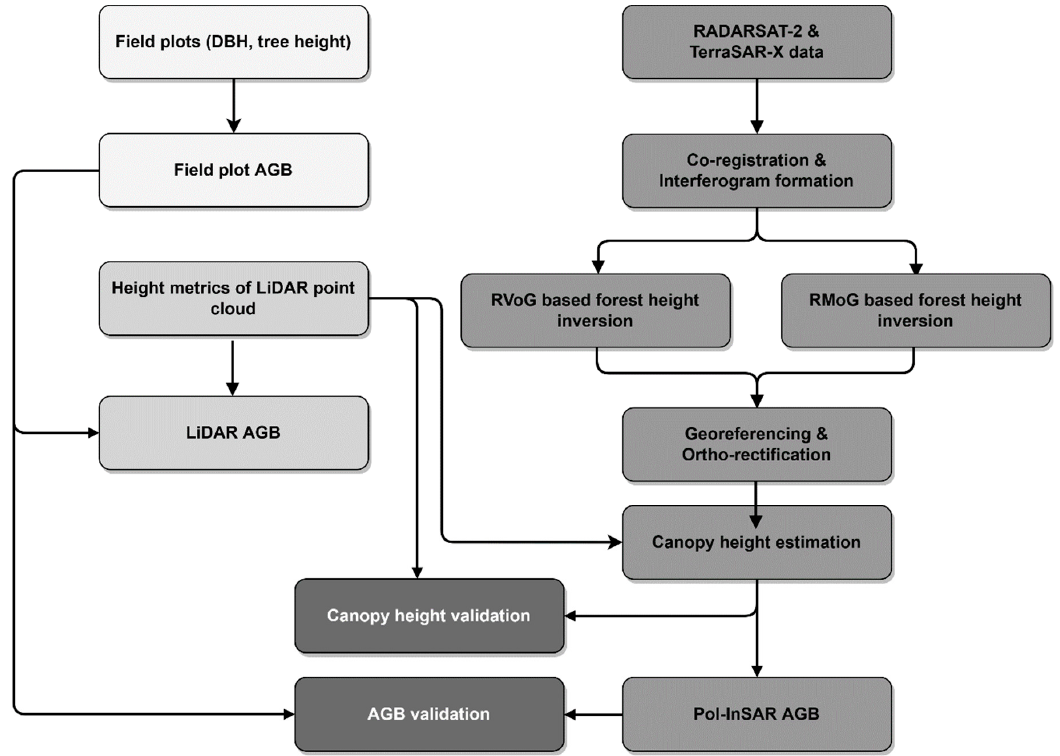
Figure 2. Workflow of the methodology applied in this study (bright grey = field data, grey = LiDAR data, medium dark grey = SAR data, dark grey = validation).